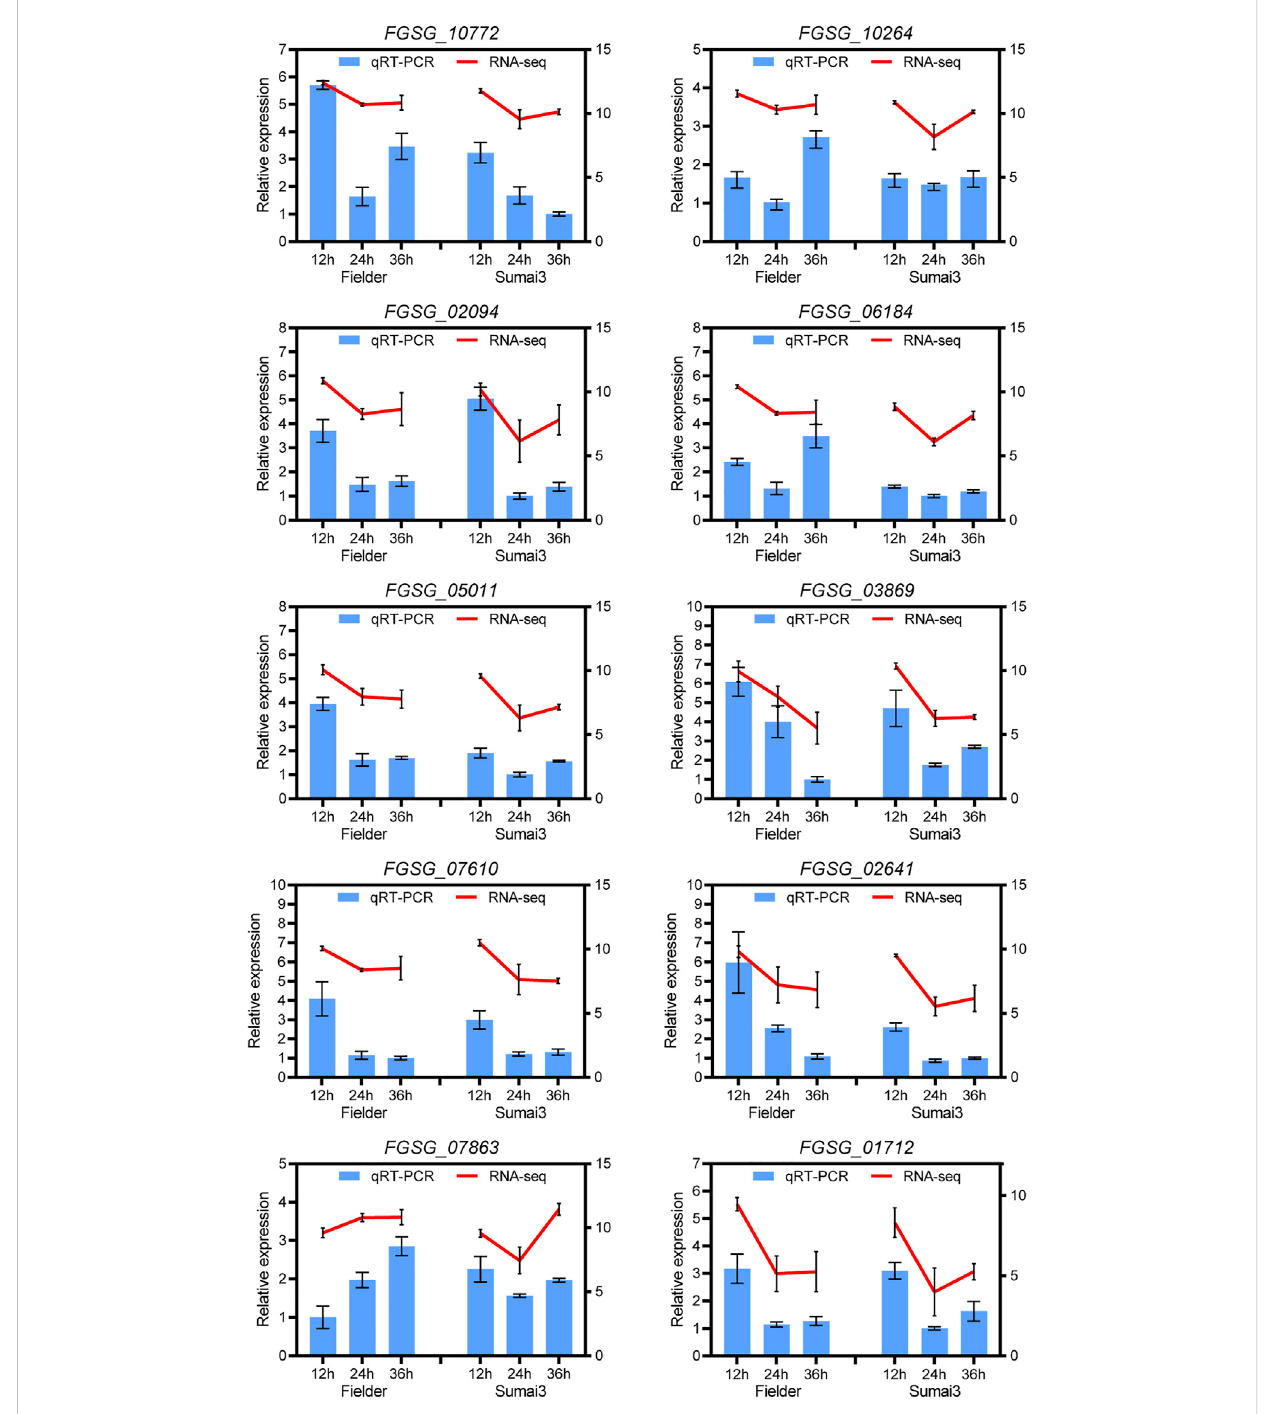
FIGURE 8 qRT-PCR analyses of ten randomly selected DEGs in Fielder and Sumai3. The left ordinate axis represents the relative expression level of DEGs by qRT-PCR, and the right ordinate axis represents the RNA-seq expression leve (log2(FPKM+1)). The Fusarium graminearum gene FgEF1A was used as internal reference and mean ± SD of data from three biological replicates was